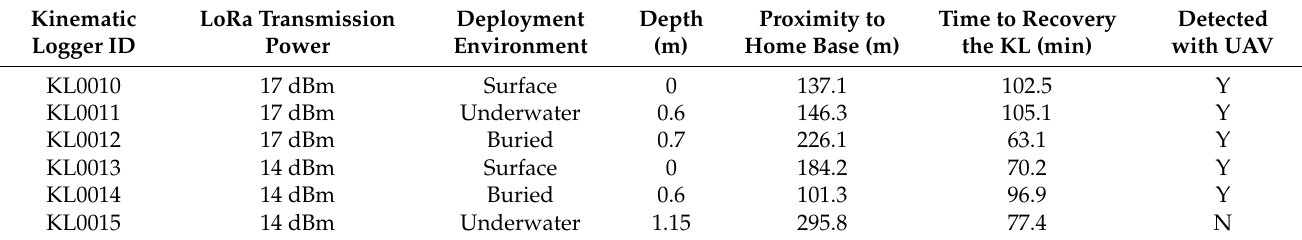
Table 2. Kinematic Loggers deployed during field recovery